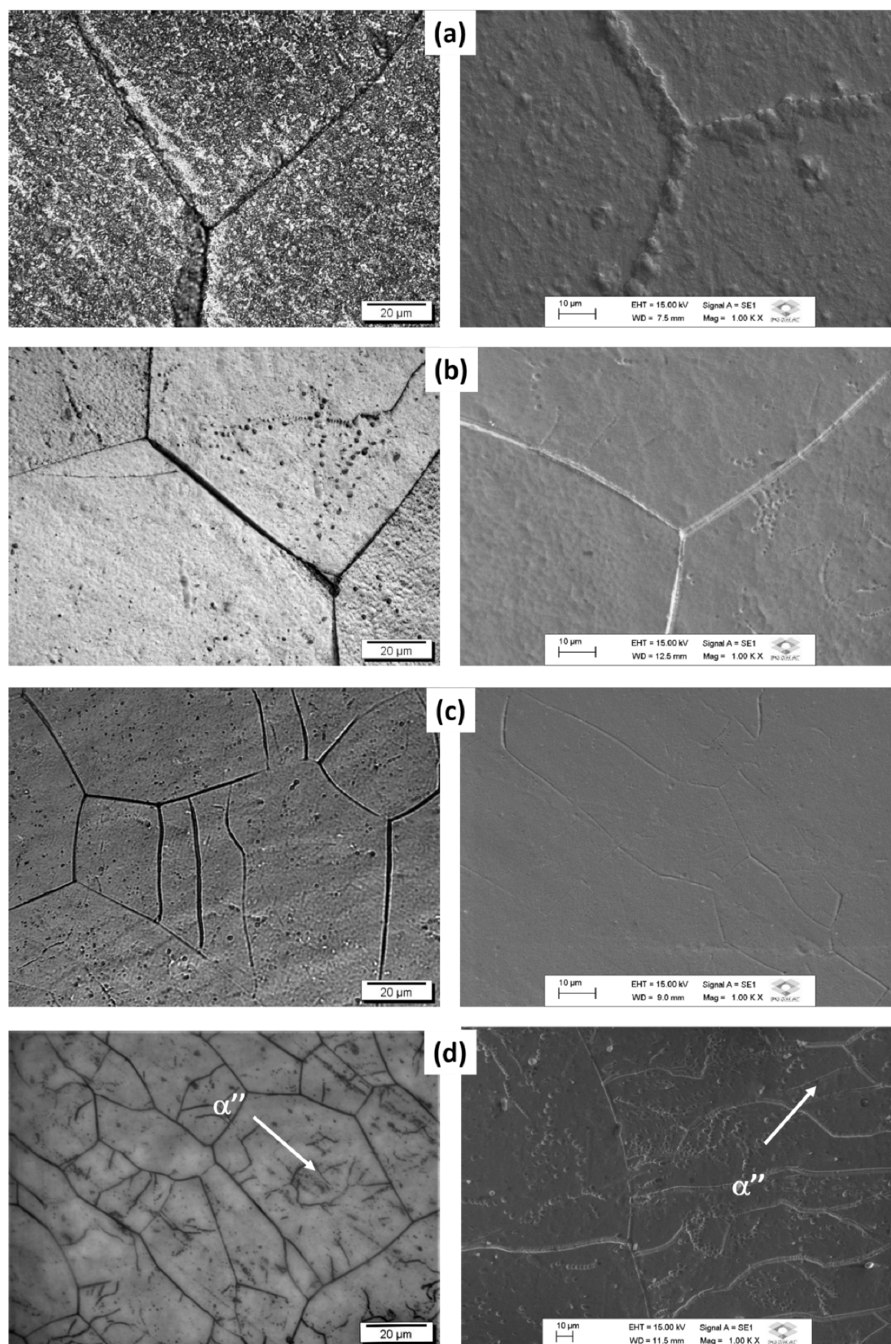
Figure 4. Visible-light ( left ) and scanning electron ( right ) microscopy images for Zr-25Ta ( a ), Zr-25Ta-15( b ), Ti-Zr-25Ta-25Ti ( c ), and Zr-25Ta-35Ti ( d ) alloys.